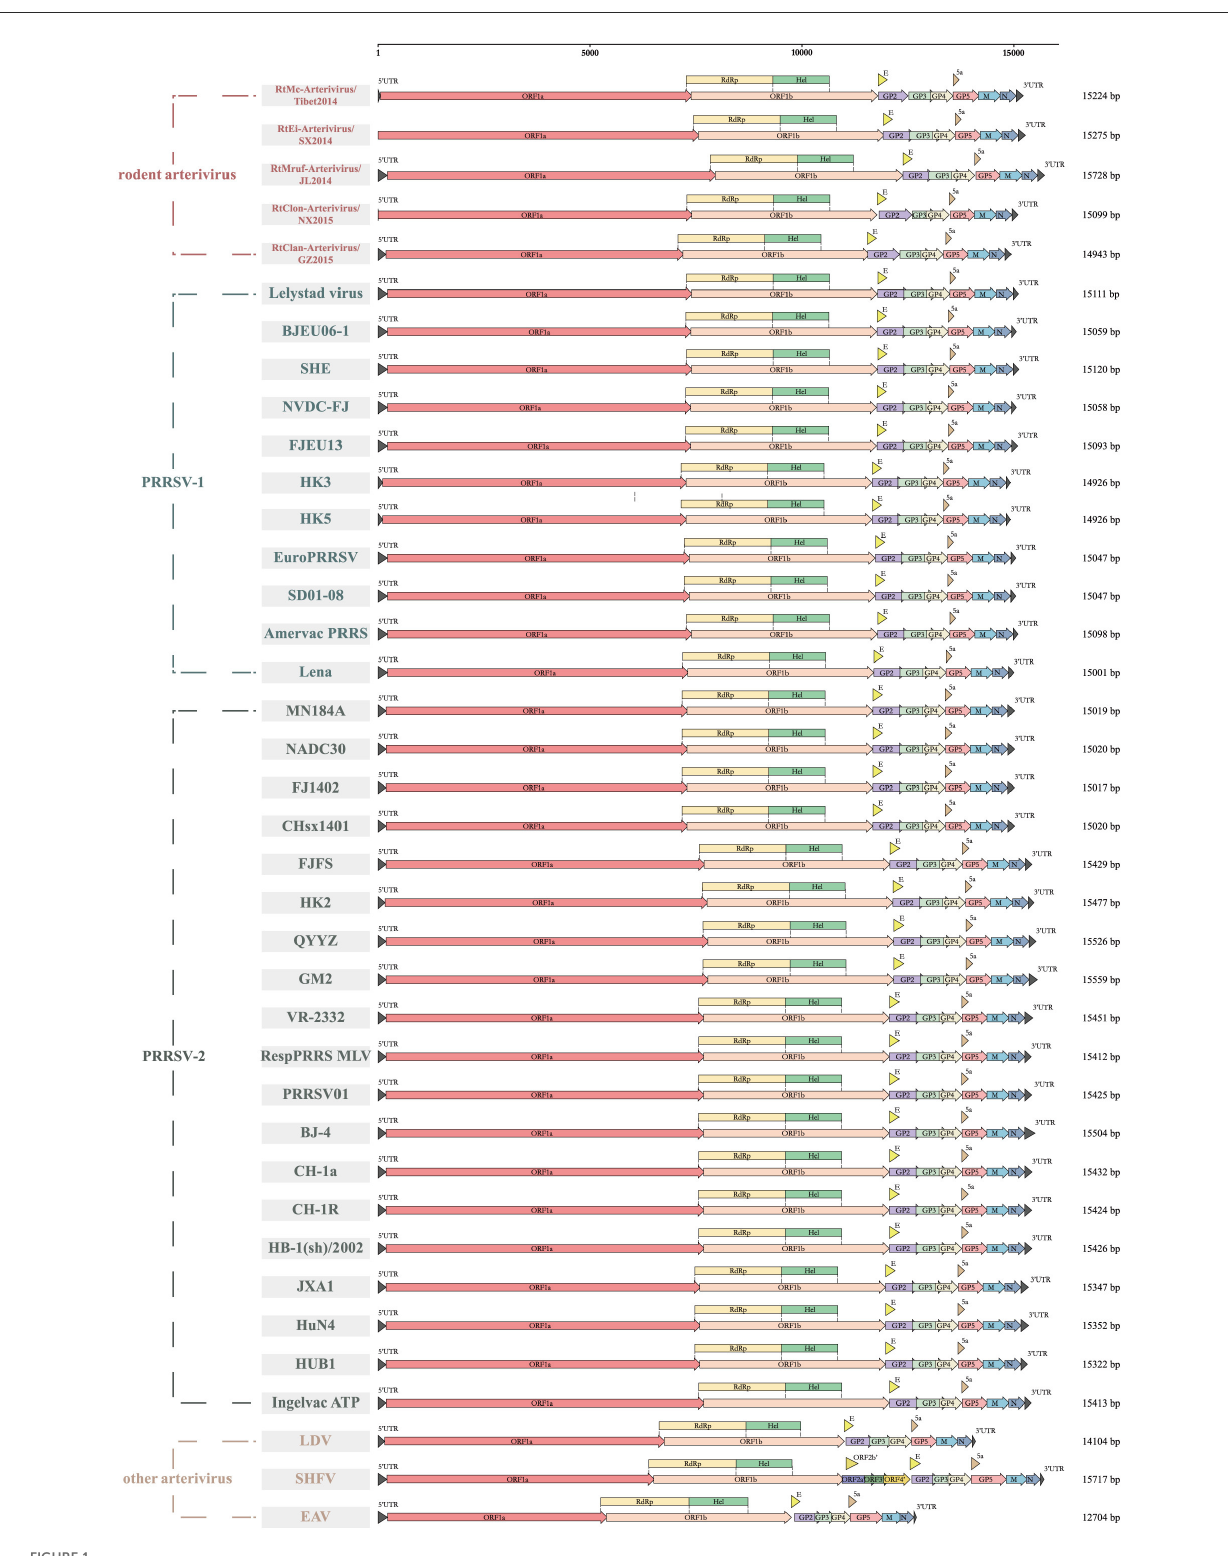
FrontiersinVeterinaryScience